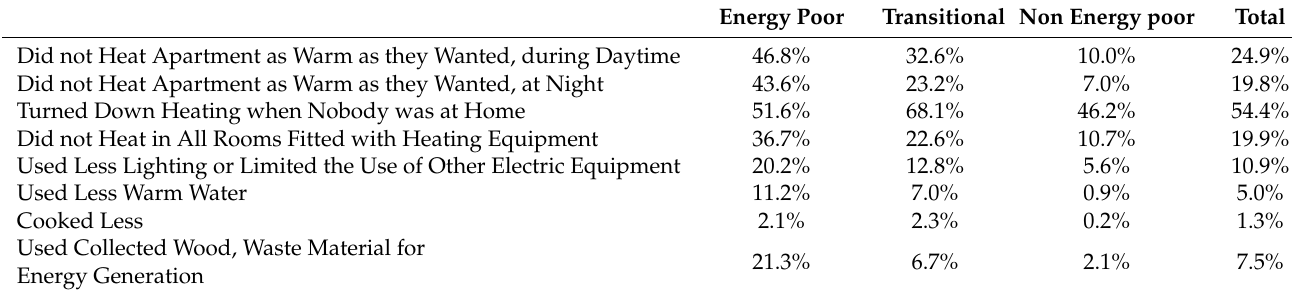
Table A2. Aspects of the use by clusters. Compiled by the